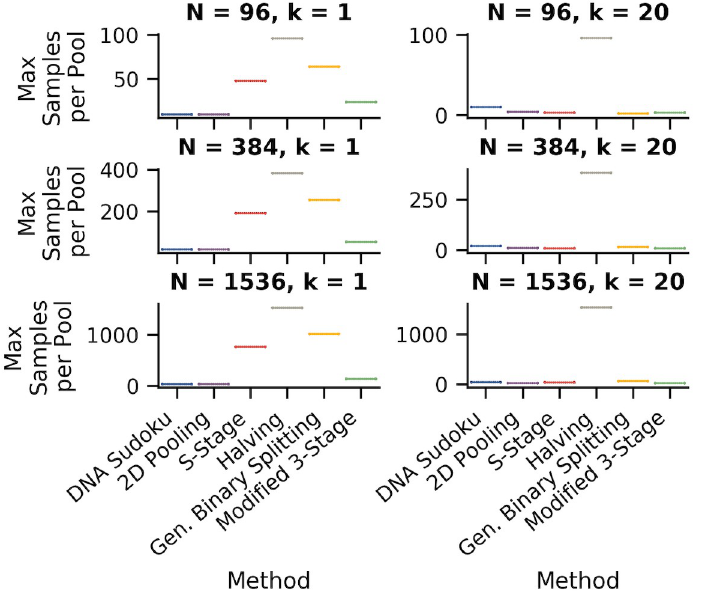
Fig 9. Comparison of the maximum number of samples per pool for each pooling method. The plots show the maximum number of samples in a single pool for each method. The left column shows simulations with one positive sample and the right column shows simulations with 20 positive samples. The rows are different sample sizes from top to bottom: 96, 384, and 1,596. These results are from the same set of simulations as shown in Fig 7.